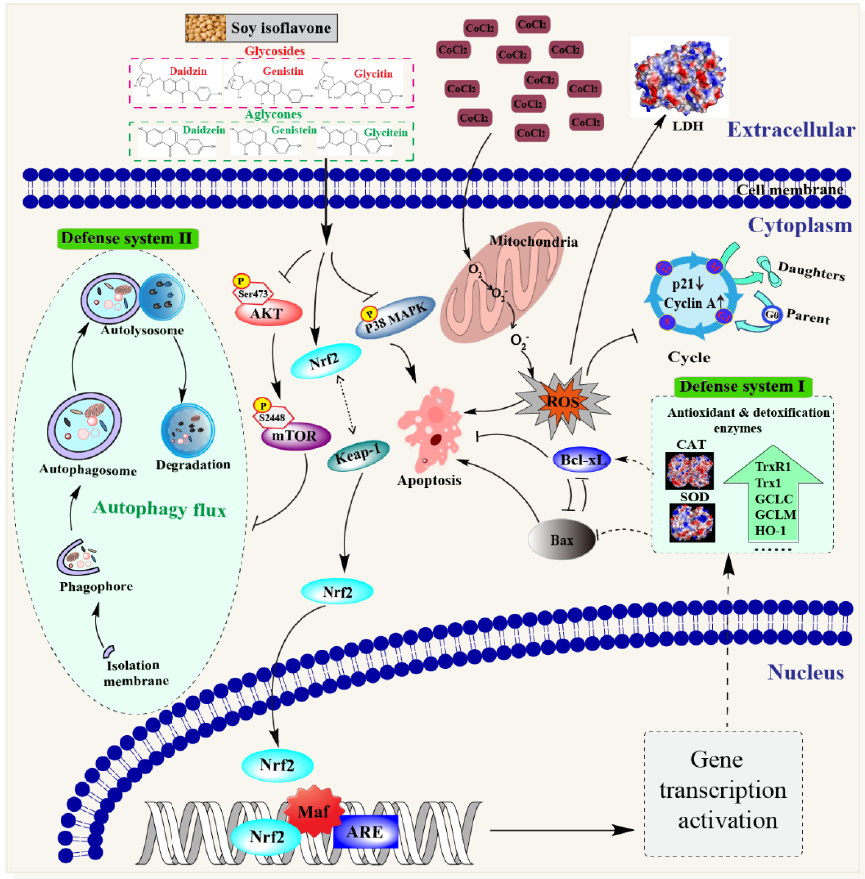
Figure 8. Schematic diagram of the potential mechanisms of the neuroprotective effect of soybean isoflavones.